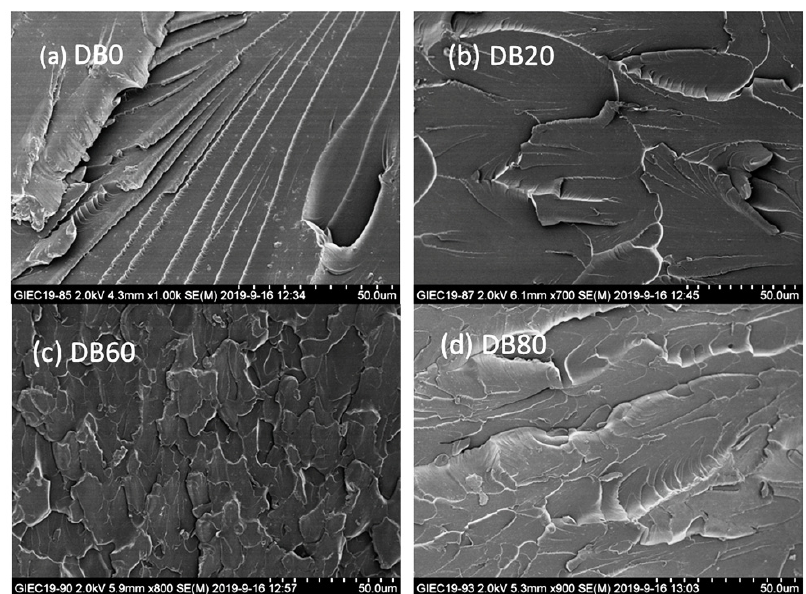
Figure 5. Scanning electron microscope (SEM) images of the fractured surface of the DB resin pre- Figure 5. SEM images of the fractured surface of the DB0 ( a ), DB20 ( b ), DB60 ( c ) and DB80 ( d ) resin pared with different added amounts of DMAP-lignin epoxide after tensile tests, ( a ) DB0, ( b ) DB20, after tensile ( c ) DB60, ( d )DB80.